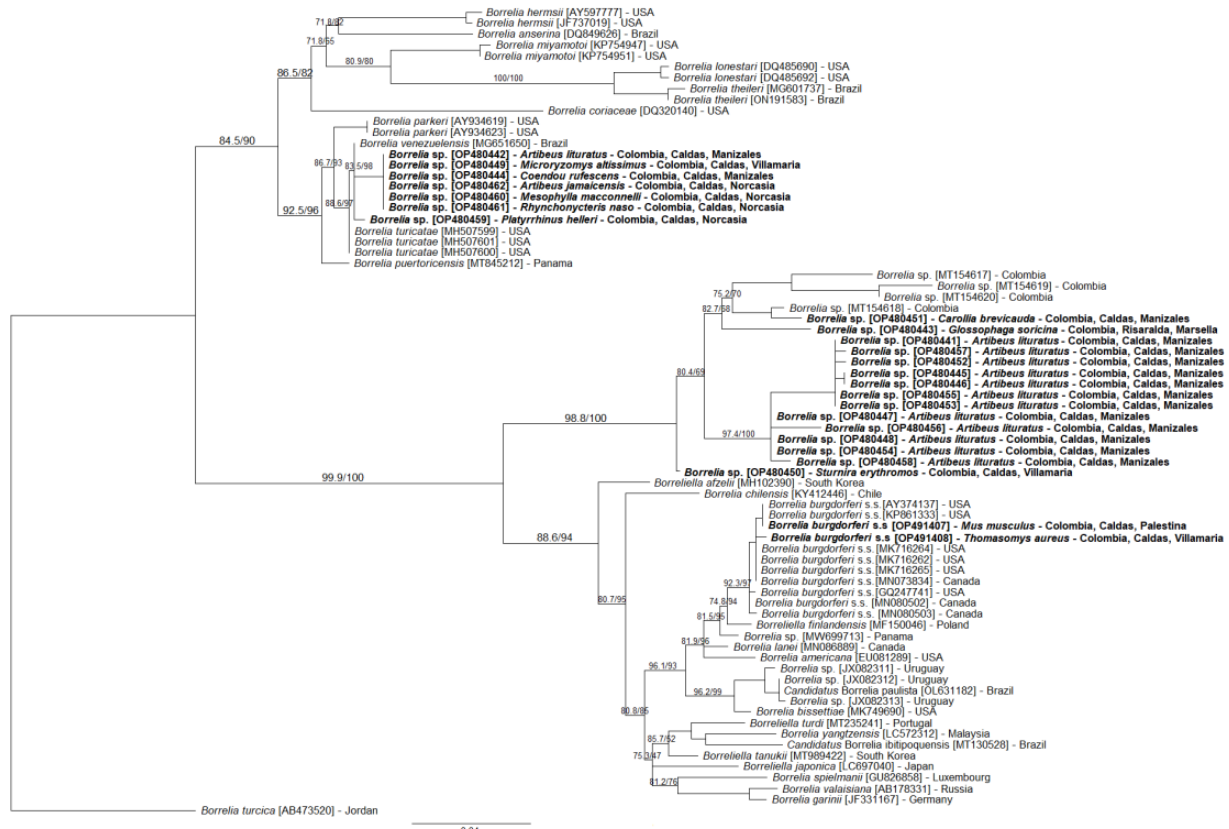
Figure 3. Phylogenetic tree of the partial sequences of the flaB gene of Borrelia species in the present study (in bold) and of the sequences in GenBank (accession numbers in parentheses), using the maximum likelihood (ML) method and the GTR + G4 + F model. Numbers at nodes are selected branch support analyses; from left to right: ultrafast bootstrap values, and Shimodaira–Hasegawa- like approximate likelihood ratio test (SH-like aLRT). The Borrelia turcica sequence was used as an outgroup.